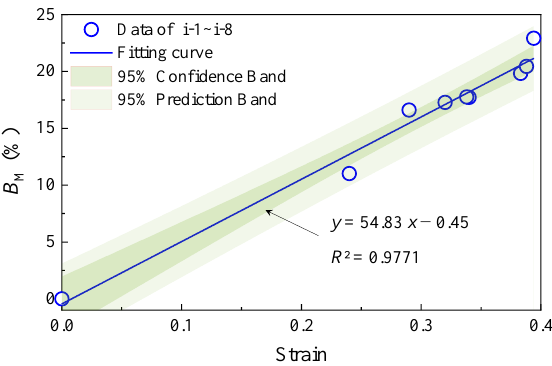
Figure 8. The fitting relationship between the breakage ratio and the strain.